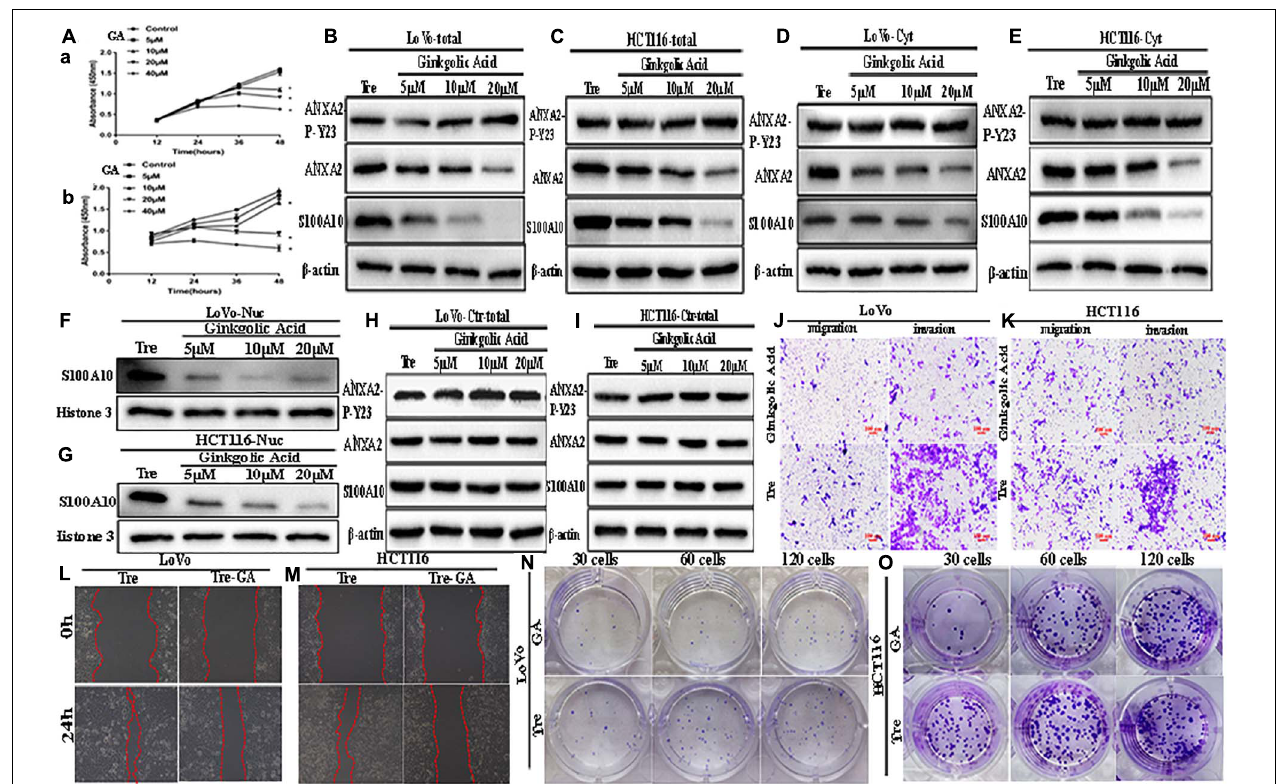
FIGURE 3 | ANXA2-P-Y23, ANXA2, and S100A10 expression in LoVo and HCT116 PGCCs with daughter cells before and after GA treatment and GA inhibits the motility, invasiveness and migration of LoVo and HCT116 PGCCs with daughter cells. (A) Effects of GA on the viability of the PGCCs with their daughter cells derived from LoVo and HCT116. Cells treated with 0 µ M GA were used as a negative control group. Data are presented as the means ± standard errors. * P < 0.05 treatment vs. control group. (a) LoVo PGCCs with their daughter cells were treated with GA at different concentrations (0, 5, 10, 20, and 40 µ M). At each time point (12, 24, 36, and 48 h), cell viability was assessed using CCK8 assay. (b) HCT116 PGCCs with their daughter cells were treated with GA at various concentrations (0, 5, 10, 20, and 40 µ M). At each time point (12, 24, 36, and 48 h), cell viability was assessed using CCK8 assay. (B) Total ANXA-P-Y23, ANXA2, and S100A10 expression in LoVo PGCCs with their daughter cells after GA treatment at 0, 5, 10, and 20 µ M for 24 h. (C) Total ANXA-P-Y23, ANXA2, and S100A10 expression in HCT116 PGCCs with their daughter cells after GA treatment at 0, 5, 10, and 20 µ M for 24h. (D) Cytoplasmic ANXA-P-Y23, ANXA2, and S100A10 expression in LoVo PGCCs with their daughter cells after GA treatment at 0, 5, 10, and 20 µ M for 24 h. (E) Cytoplasmic ANXA-P-Y23, ANXA2, and S100A10 expression in HCT116 PGCCs with their daughter cells after GA treatment at 0, 5, 10, and 20 µ M, respectively, for 24 h. (F) Nuclear S100A10 expression in LoVo PGCCs with their daughter cells after GA treatment at 0, 5, 10, and 20 µ M for 24 h. (G) Nuclear S100A10 expression in HCT116 PGCCs with their daughter cells after GA treatment at 0, 5, 10, and 20 µ M, respectively, for 24 h. (H) Total ANXA-P-Y23, ANXA2, and S100A10 expression in LoVo control cells after GA treatment at 0, 5, 10, and 20 µ M for 24 h. (I) Total ANXA-P-Y23, ANXA2, and S100A10 expression in HCT116 control cells after GA treatment at 0, 5, 10, and 20 µ M for 24 h. (J) The migration and invasion ability of LoVo PGCCs and daughter cells before and after 20 µ M of GA treatment for 24 h (100 × ). (K) The migration and invasion ability of HCT116 PGCCs with daughter cells before and after 20 µ M of GA treatment for 24 h (100 × ). (L) Wound-healing assay of LoVo PGCCs with daughter cells before and after 20 µ M of GA treatment for 24 h. (M) Wound-healing assay of HCT116 PGCCs and daughter cells before and after 20 µ M of GA treatment for 24 h. (N) Colony formation of LoVo PGCCs and daughter cells before and after 20 µ M of GA treatment for 24 h. (O) Colony formation of HCT116 PGCCs and daughter cells before and after 20 µ M of GA treatment for 24 h. Tre, cells treated with CoCl 2 ; Cyt, cytoplasm; Nuc,